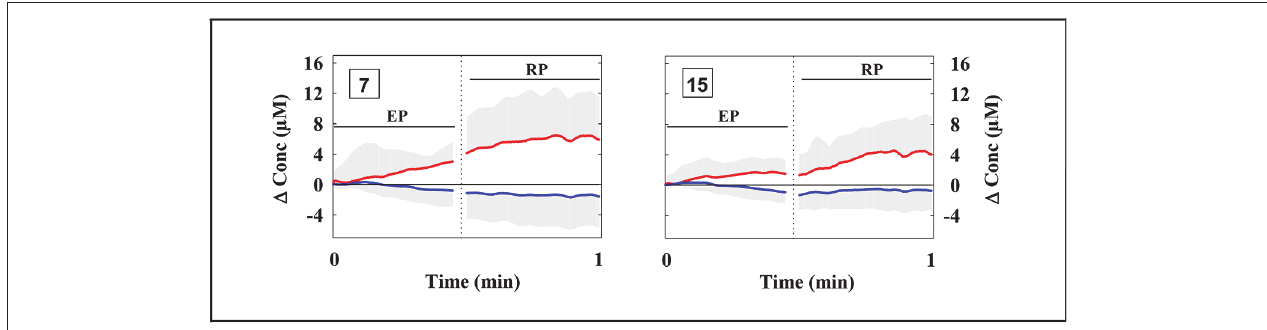
FIGURE 3 | Grand average of the cortical oxygenation changes over the ventrolateral prefrontal cortex (channels 7 and 15) during the LMT after the subtraction of O 2 Hb and HHb changes occurring during the